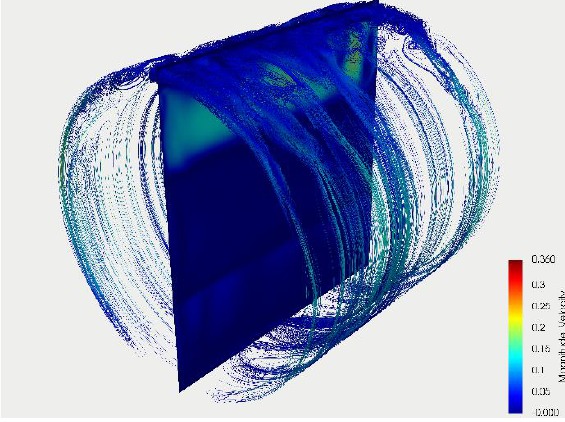
Fig. 24. The velocity field is plotted for the case d / D = 0.9